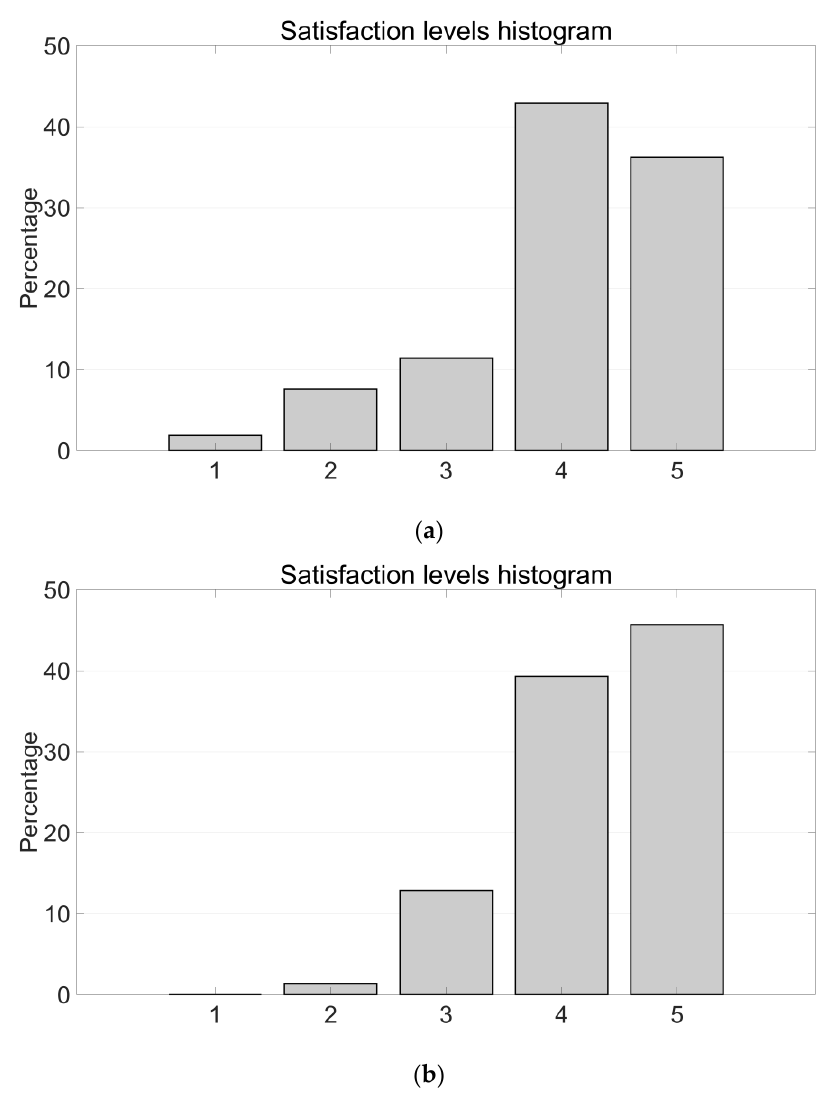
Figure 7. Satisfaction levels from 1 (lowest satisfaction) to 5 (highest satisfaction). Histogram in the different experimental groups: ( a ) traditional visit; ( b ) AR visit.